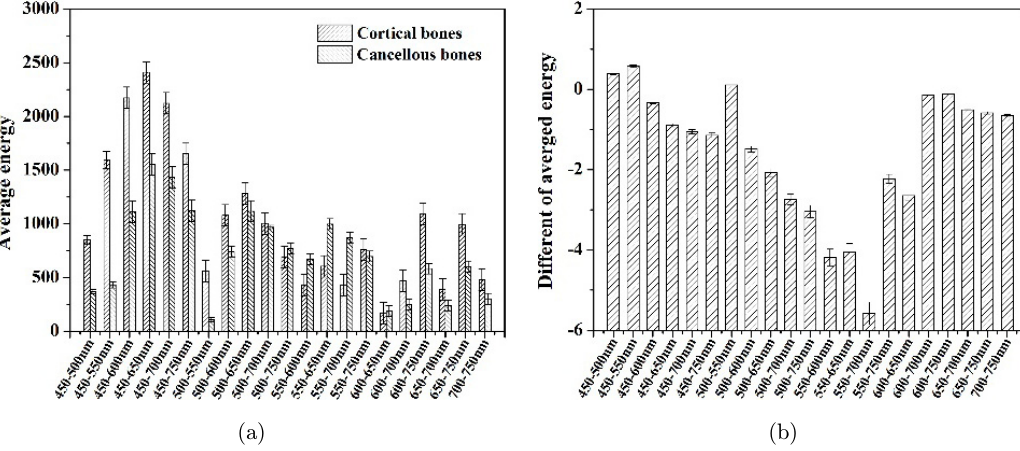
Fig. 4. Average energy from di®erent groups based on the two tissues with porcine vertebra experiment (a) the average energy from di®erent band groups, (b) the di®erence of average energy from di®erent band groups, (c) the average energy from di®erent frequency section (550 nm to 750 nm), (d) the di®erence of average energy from di®erent frequency section (550 nm to 750